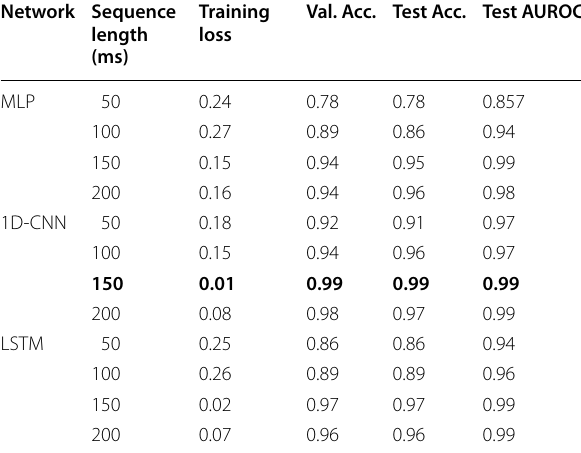
Values pertaining to model’s best performance are highlighted in bold